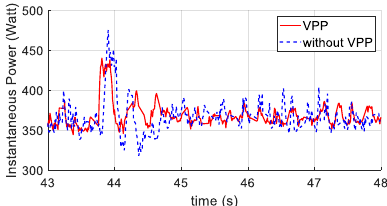
Figure 16. Instantaneous power during the second flight test scenario.